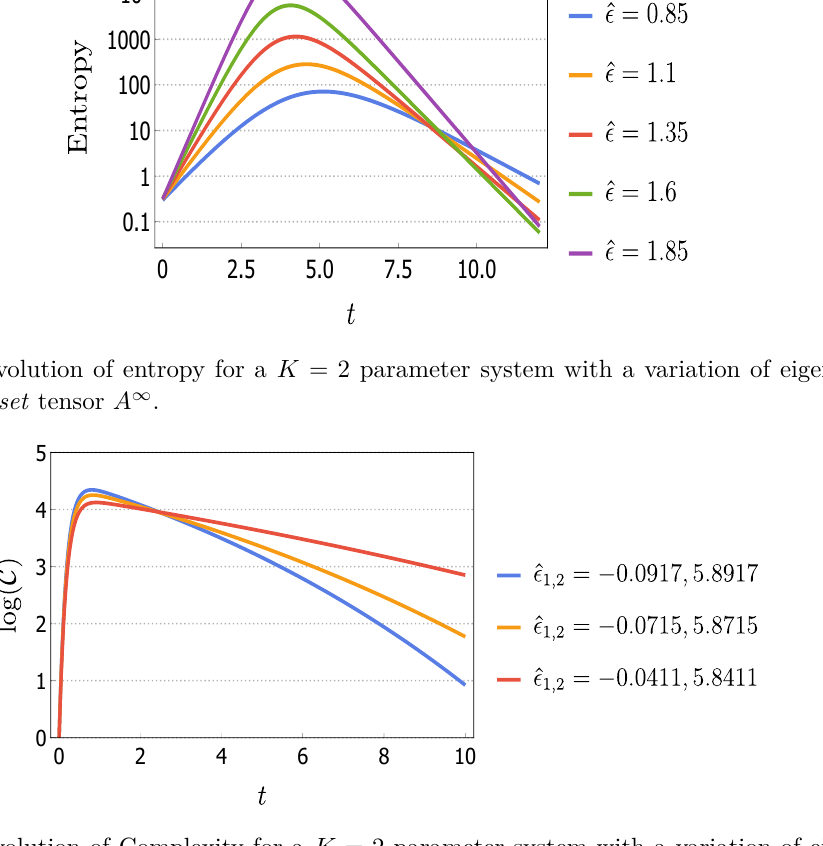
Figure 5 . Evolution of Complexity for a K = 2 parameter system with a variation of eigenvalue of Encoder-Dataset tensor A ∞ in a non-chaotic